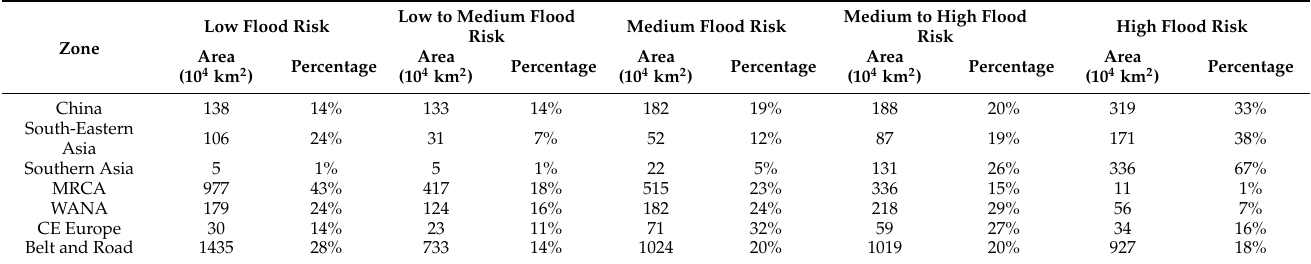
Table 4. “Belt and Road” flood impact area and proportion statistics